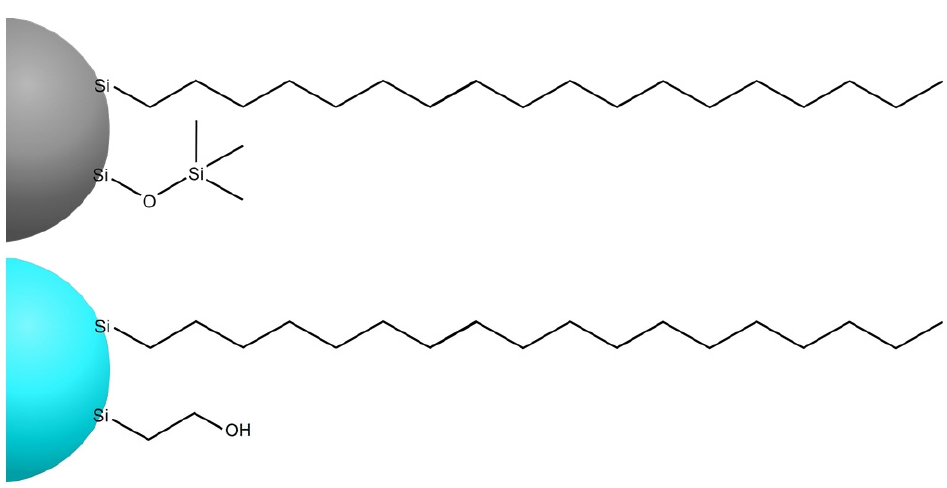
Figure 2. Octadecyl-bonded silica particles with trimethylsilane ( top ) and with polar ethanol ( bottom ) end-capping groups.